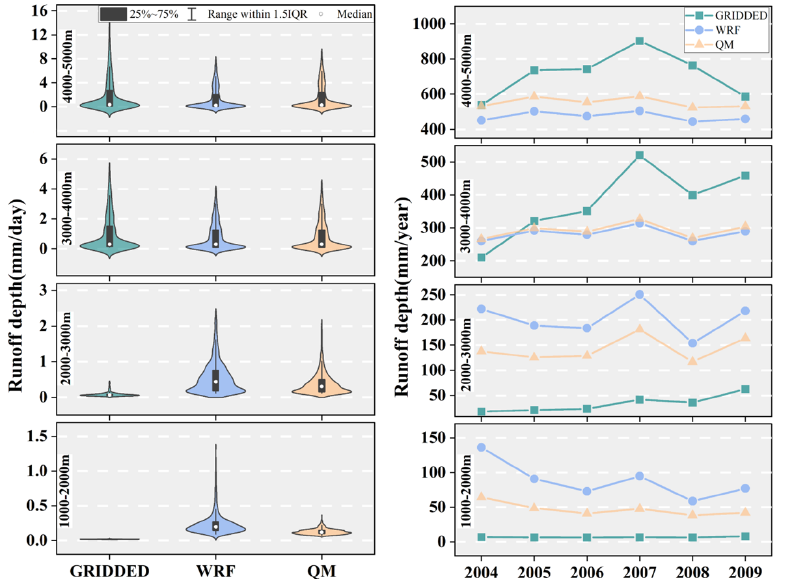
Figure 9. The left displays the altitude-related frequency distribution of simulated runoff depth using different datasets (the GRIDDED precipitation, the WRF downscaled precipitation, and the QM frequency-corrected precipitation data), and the right shows the corresponding annual runoff depth trend at different altitudes. The IQR used in the legend of the runoff depth frequency map denotes the interquartile